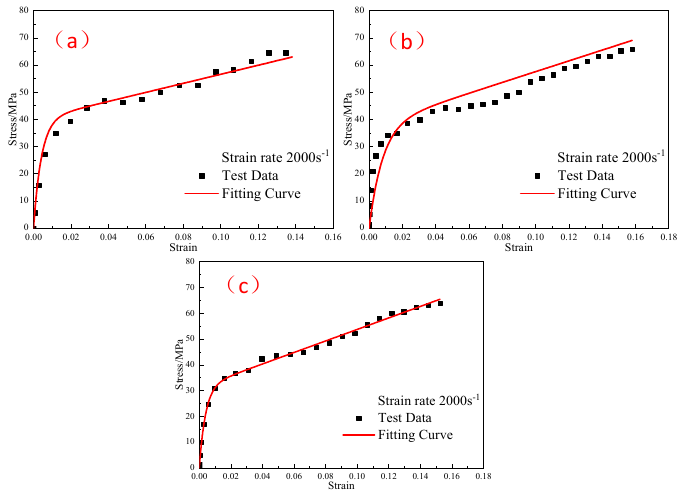
Figure 17. Validation of the reinforced Al/PTFE constitutive model considering the pressing pressure: ( a ) 400 MPa; ( b ) 600 MPa; ( c ) 800 MPa.